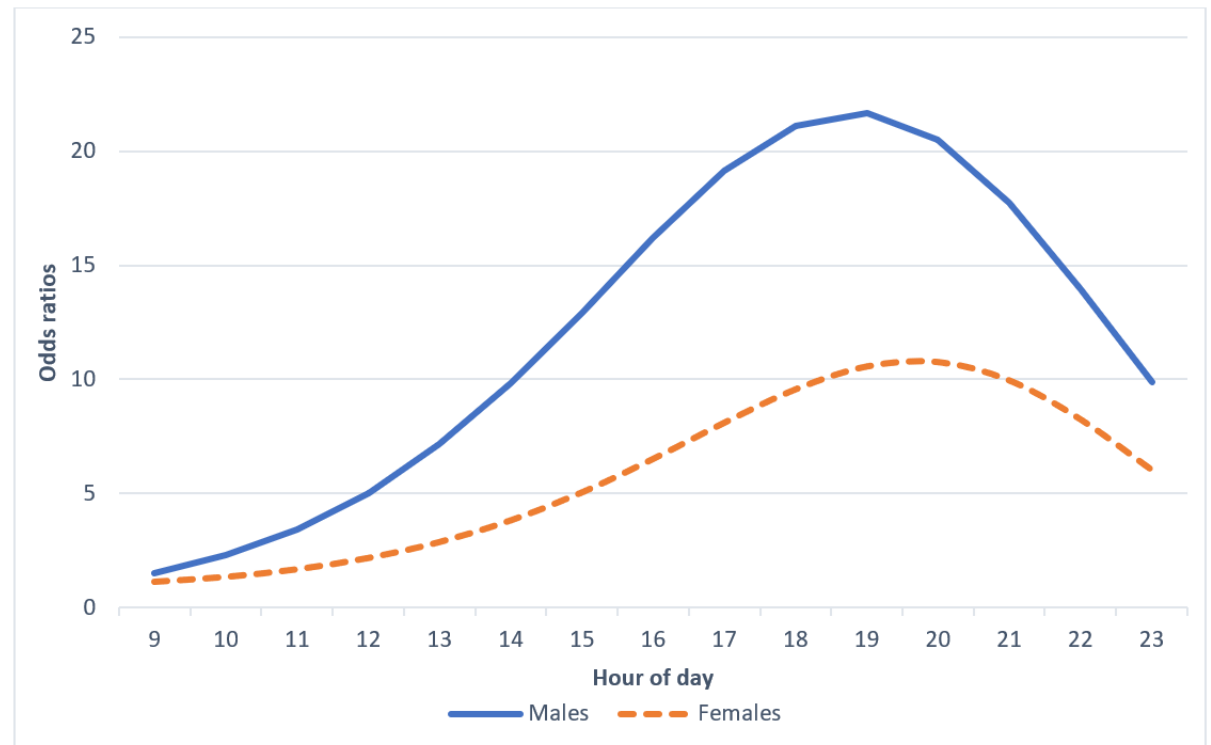
Figure 2. Sex differences in odds ratios of obtaining average moderate-to-vigorous physical activity before each hour of